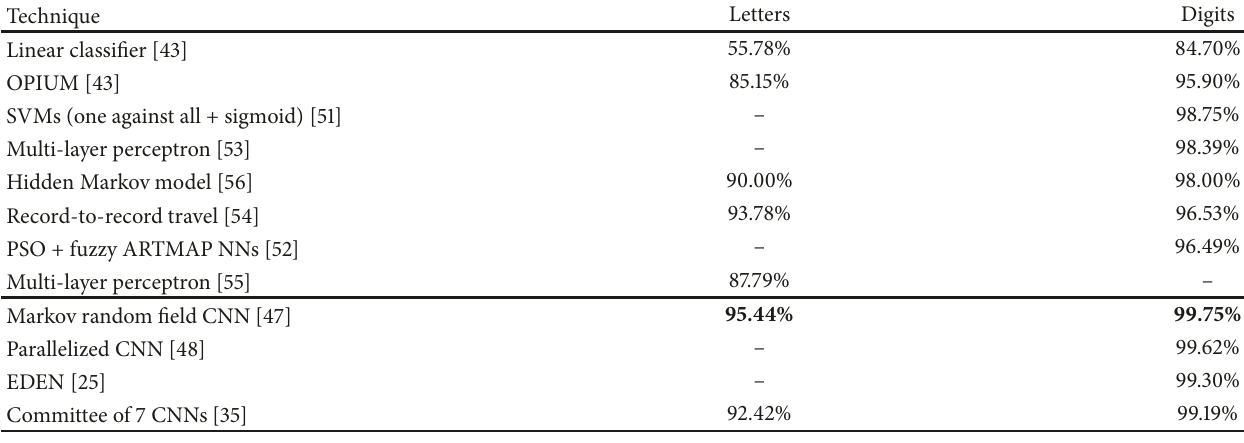
Table 3: Side-by-side comparison of the results for the EMNIST dataset along with the reported accuracy, including works using similar datasets from NIST Special Database 19.